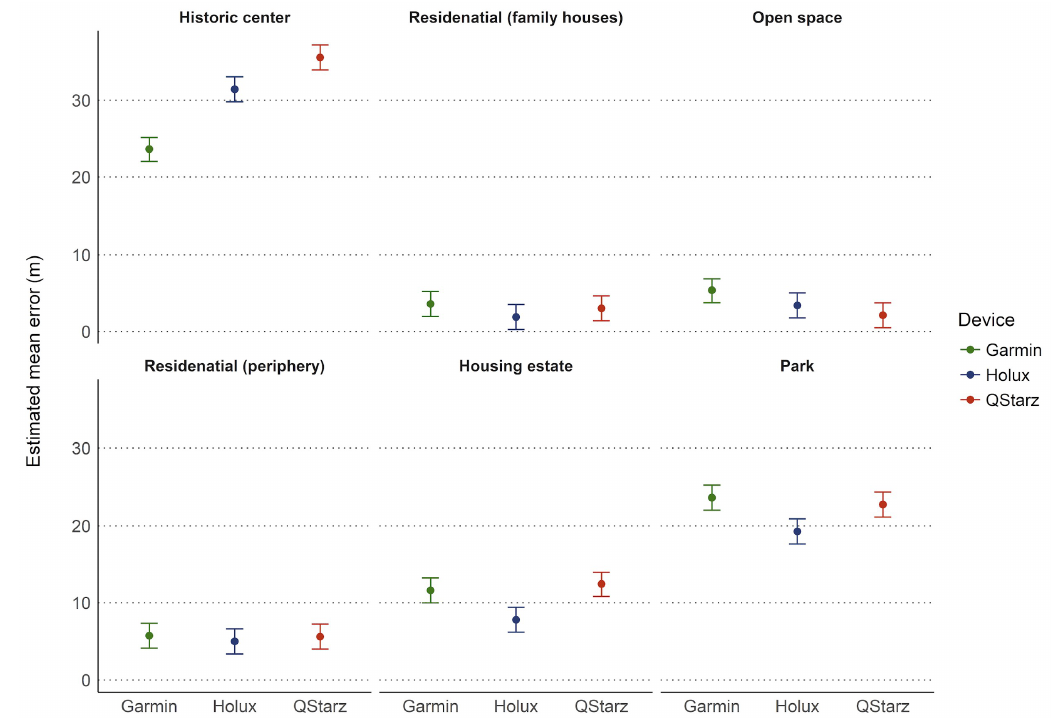
Figure 11. Estimated mean error by type of device across different sites. For the measured points, we also determined the size of the CEP radius, which appro- priately reflects both the validity and reliability of the tested instruments and